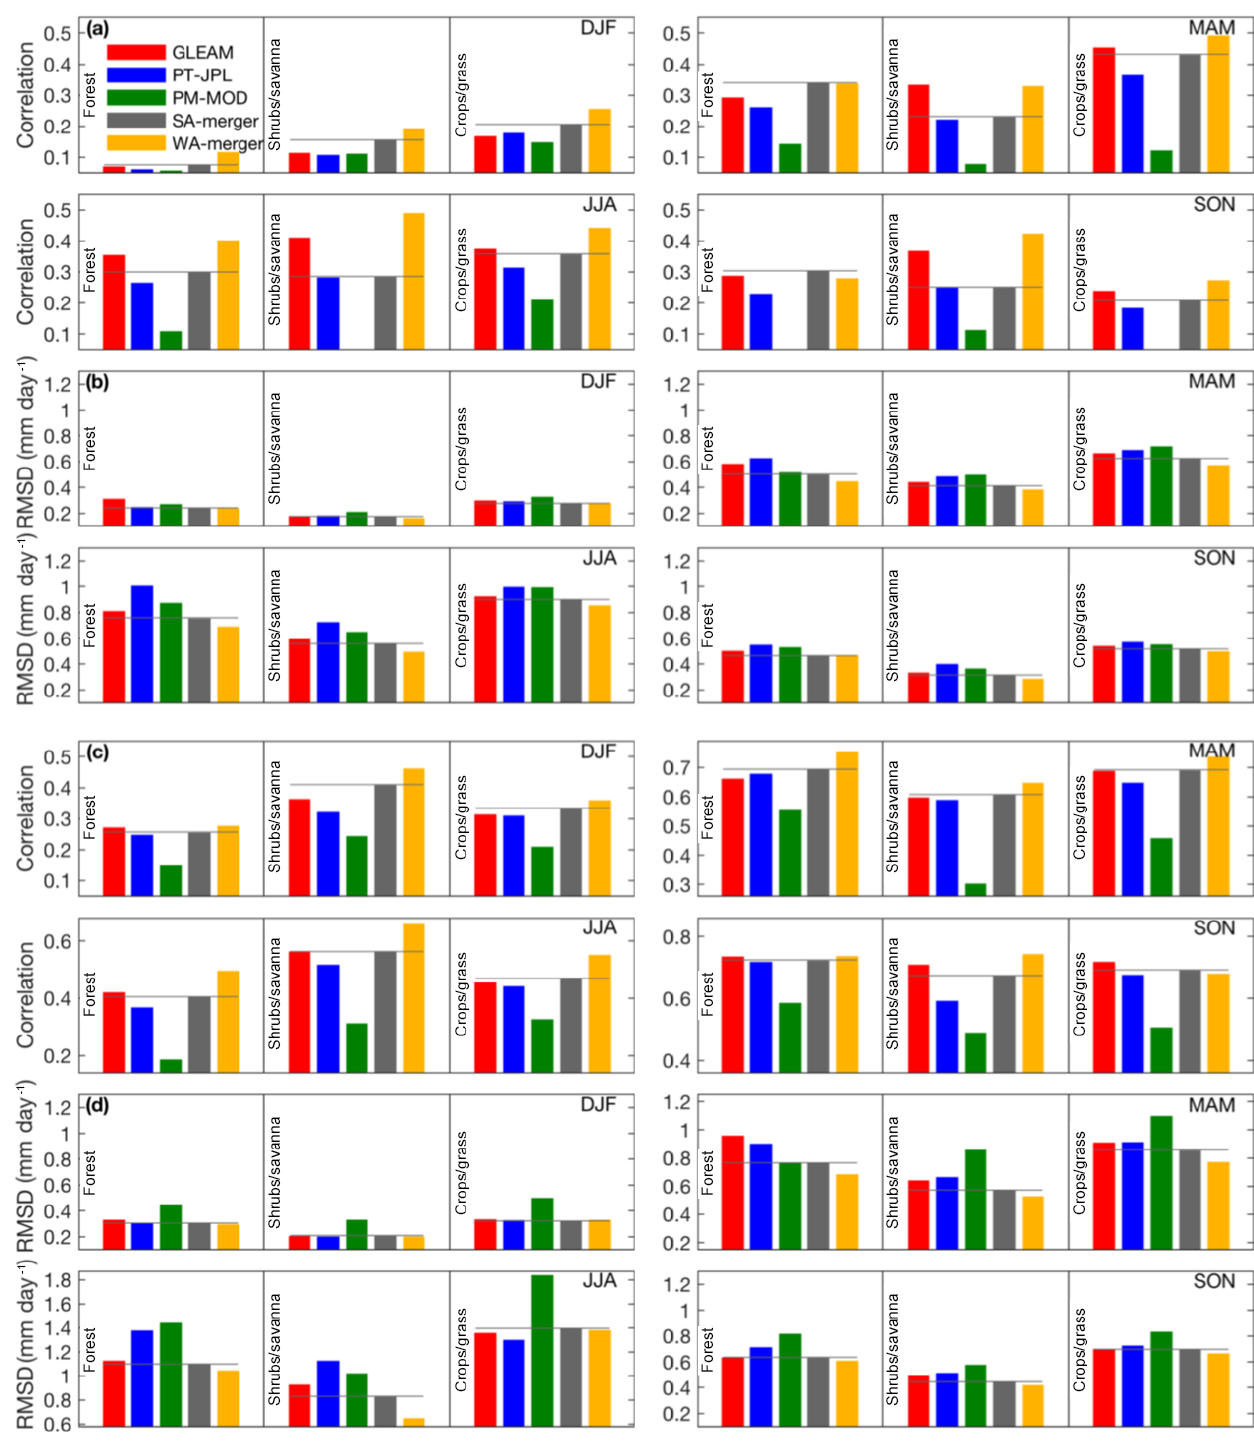
Figure 7. Season and land-cover averaged ET correlations and RMSD of the tower and the different products ( a and b for the ET anomalies, c and d for the ET absolute values). To highlight differences with SA-merger, a grey line has been added to its bar. Note that the axes are not identical, but they cover similar ranges (0.5 for the correlation, 1.2mmday − 1 for the